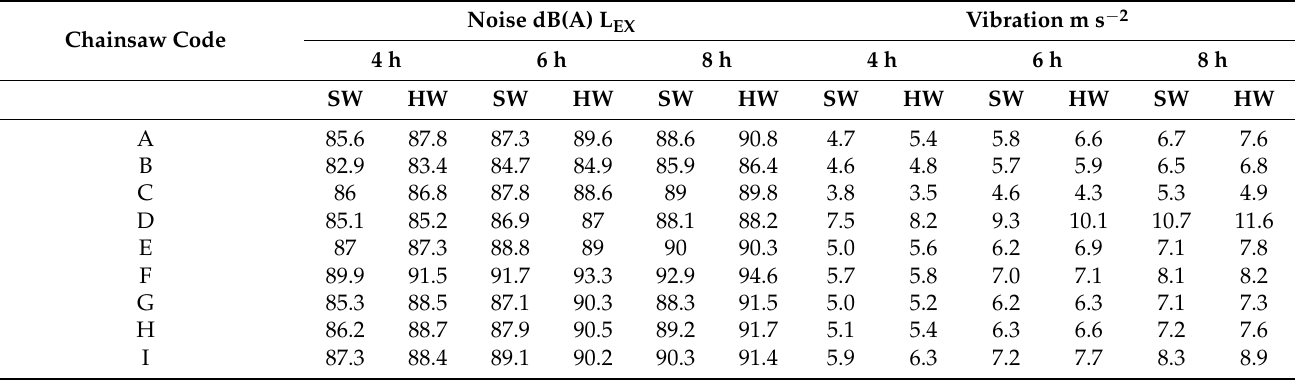
Figure 5. Average 8 h A-weighted equivalent continuous noise level during cross-cutting phase. Table 4. The noise and vibrations emissions of tested chainsaws considering different daily exposure values (4, 6, and 8 h